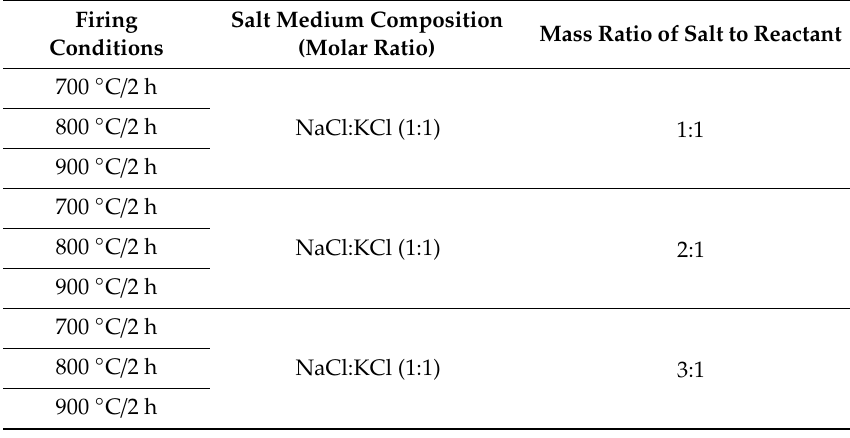
Table 1. Synthesis conditions and batch of Bi 4 Ti 3 O 12 .